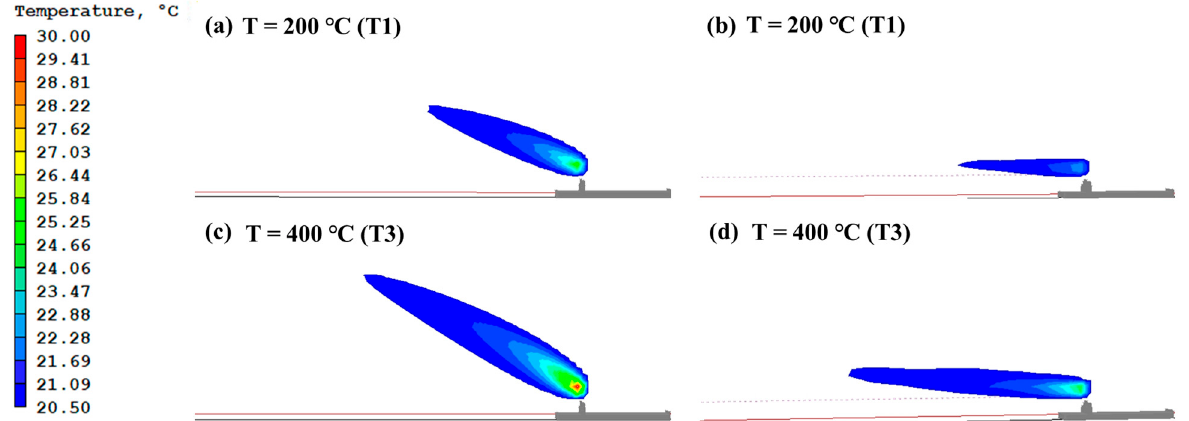
Figure 12. The vertical temperature contours in the S4-V2 scenario with a wind speed of 3 m/s: ( a ) stationary source of T1; ( b ) moving source of T1; ( c ) stationary source of T3; and ( d ) moving source of T3.